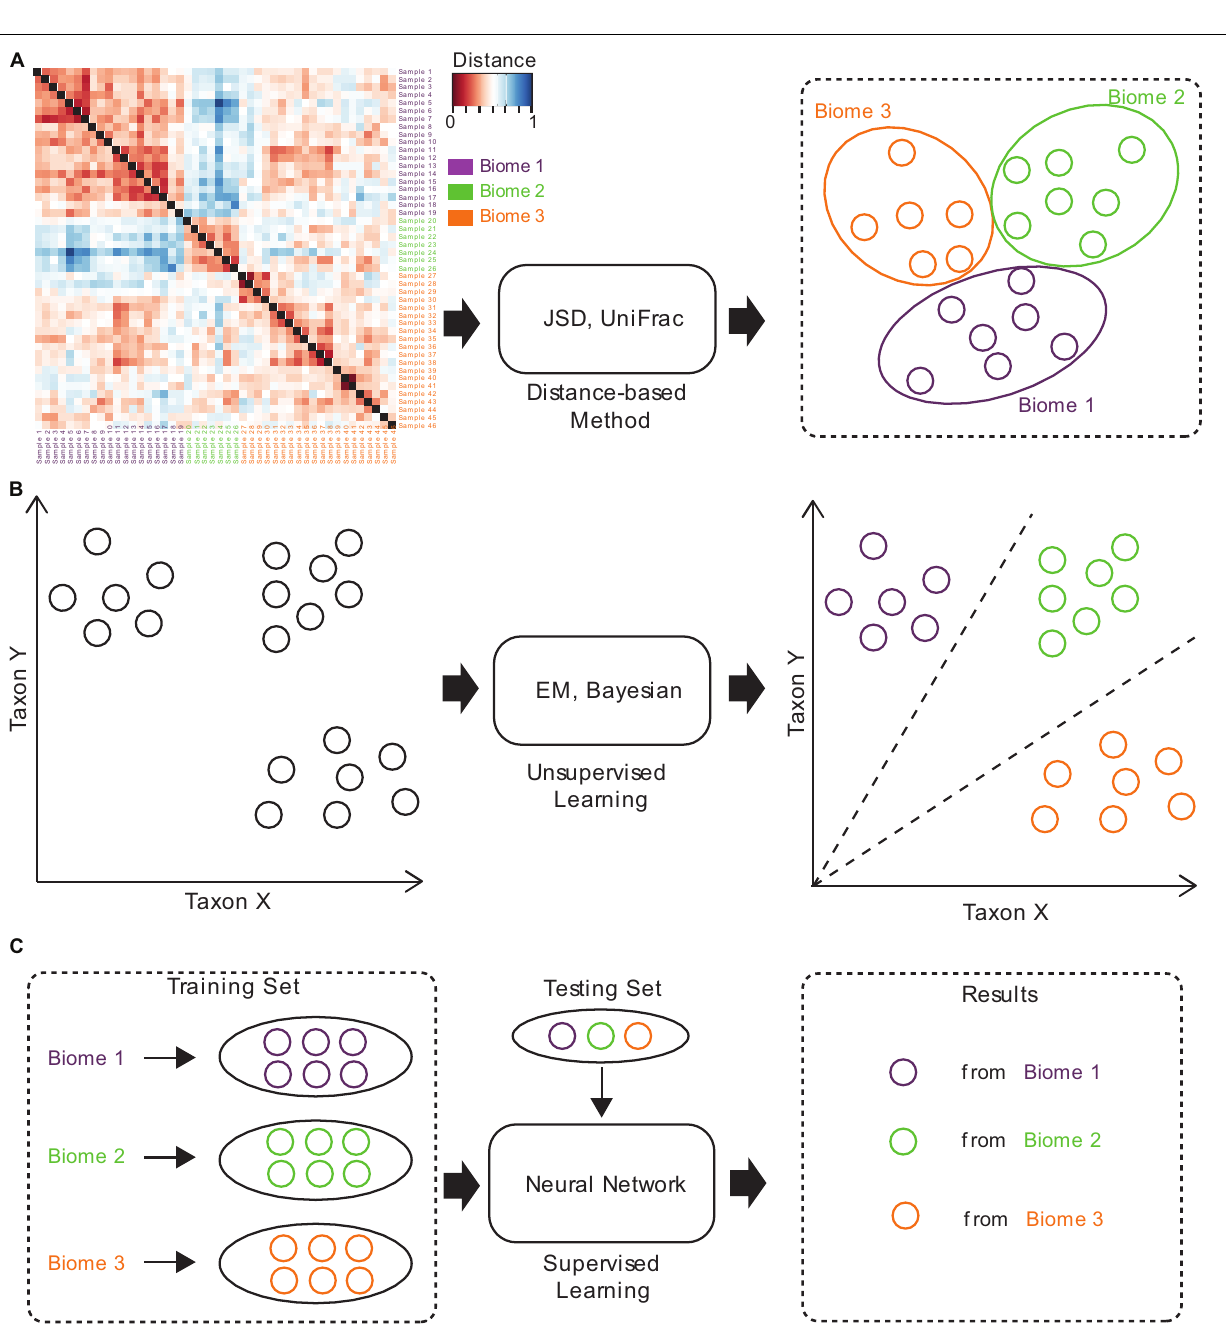
supervised methods include the Random Forest (RF) model (Roguet et al., 2018), as well as the neural network (NN) model (see text footnote 1). Since supervised methods take into consideration the specific features of a set of samples from similar niches, they are tolerant to noises in samples, but can still discover similar samples even from distant niches.